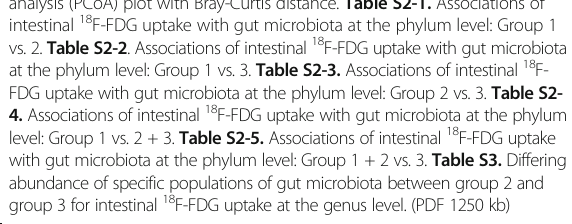
analysis (PCoA) plot with Bray-Curtis distance. Table S2-1. Associations of intestinal 18 F-FDG uptake with gut microbiota at the phylum level: Group 1 vs. 2. Table S2-2 . Associations of intestinal 18 F-FDG uptake with gut microbiota at the phylum level: Group 1 vs. 3. Table S2-3. Associations of intestinal 18 F- FDG uptake with gut microbiota at the phylum level: Group 2 vs. 3. Table S2- 4. Associations of intestinal 18 F-FDG uptake with gut microbiota at the